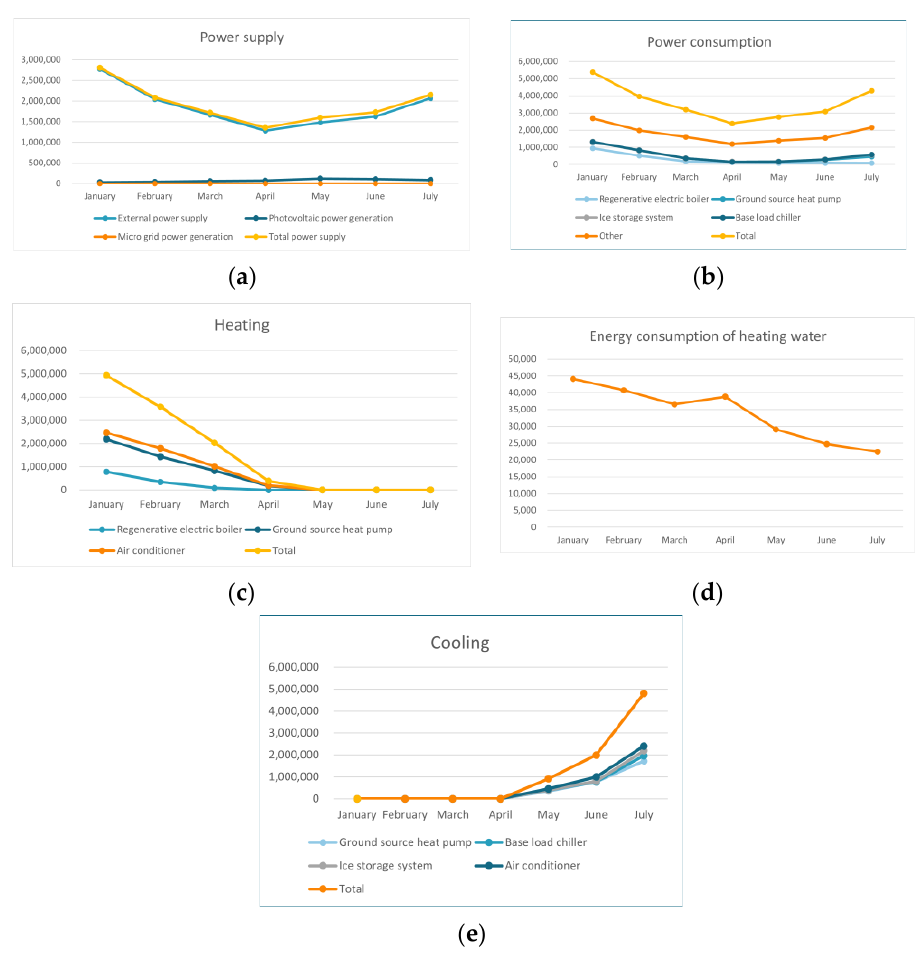
Figure 5. Energy supply and use characteristics of IES. ( a ) Power supply. ( b ) Power consumption. ( c ) Heating. ( d ) Energy consumption of heating water. ( e )